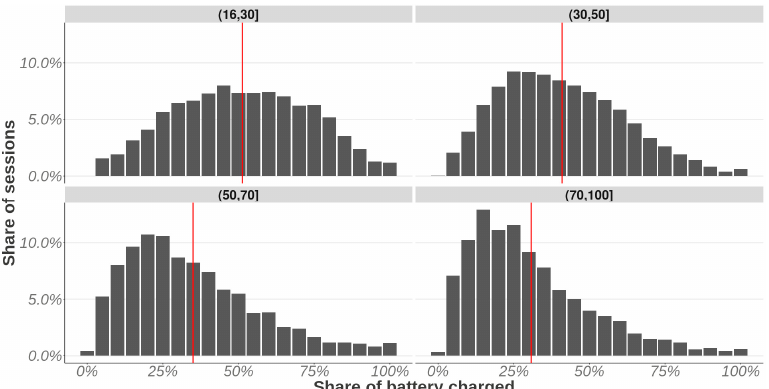
Figure 4. Energy charged relative to battery capacity for ranges of battery capacity. Red line indicates average value.